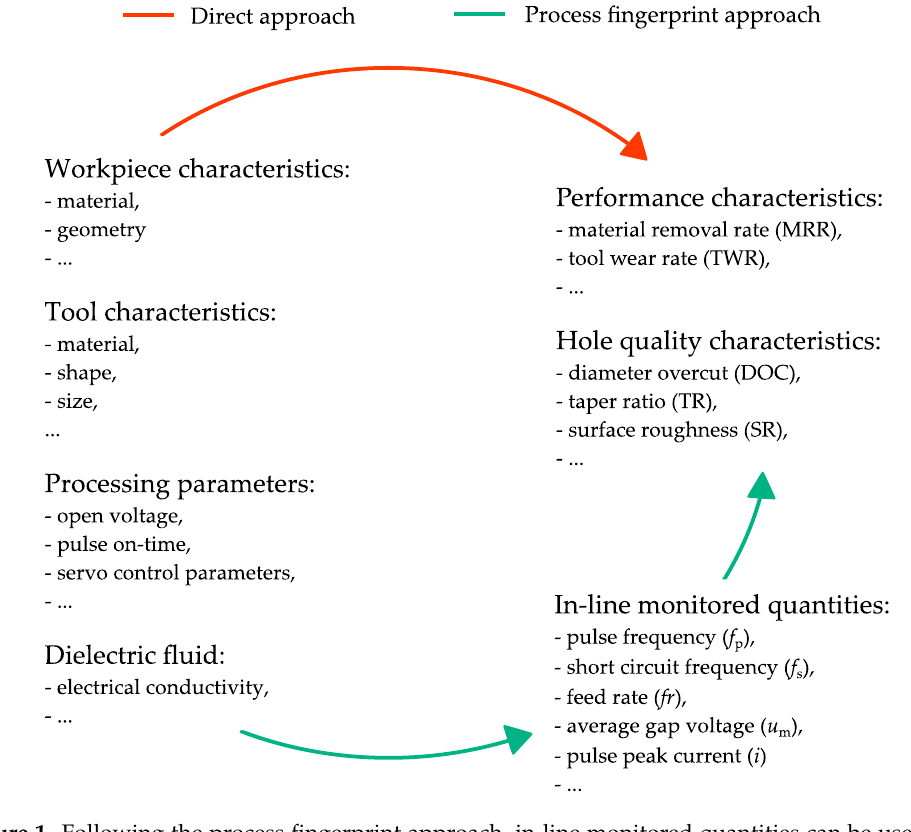
Figure 1. Following the process fingerprint approach, in-line monitored quantities can be used